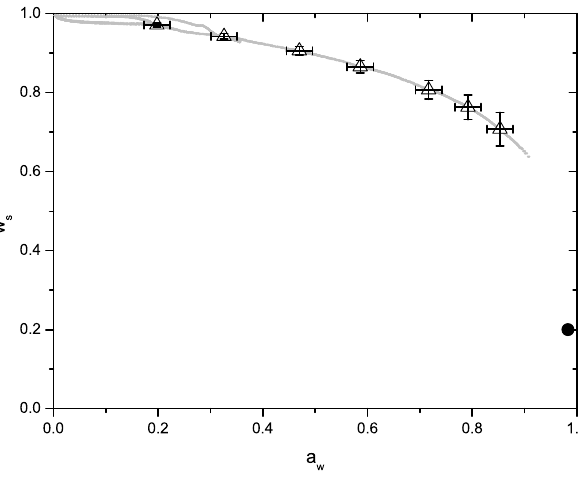
Figure 5. Mass growth data retrieved from radius measurements of Fig. 3c plotted as mass fraction of solute vs. a w (gray line). The black circle marks a bulk data point of the saturated solution. We pick some discrete data points at humidities at which the particle is in equilibrium with the gas phase (open triangles) for